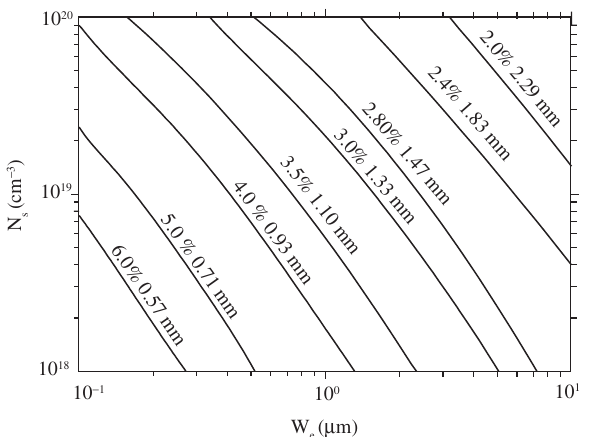
Figure 3. Metal-contacted recombination current density, J (%) and spacing between fingers, s vs. surface doping concentration, and thickness, W s e